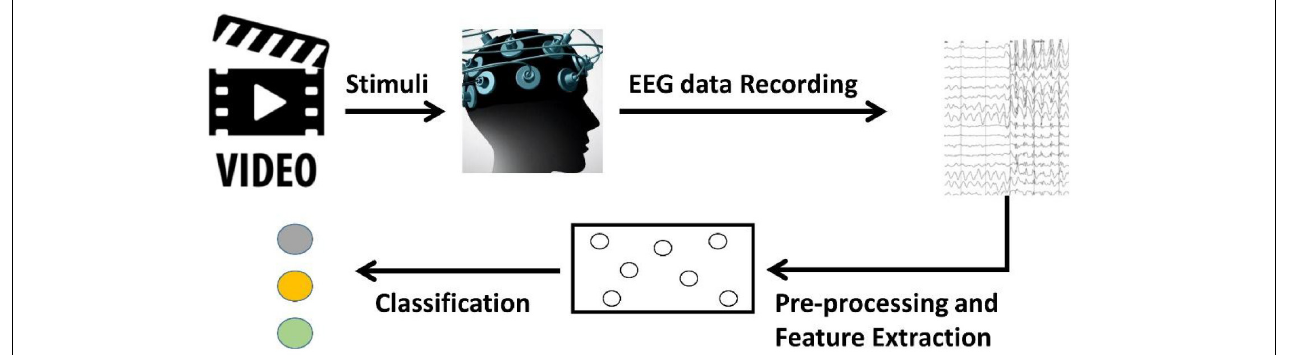
FIGURE 1 | Process flow for brain-computer